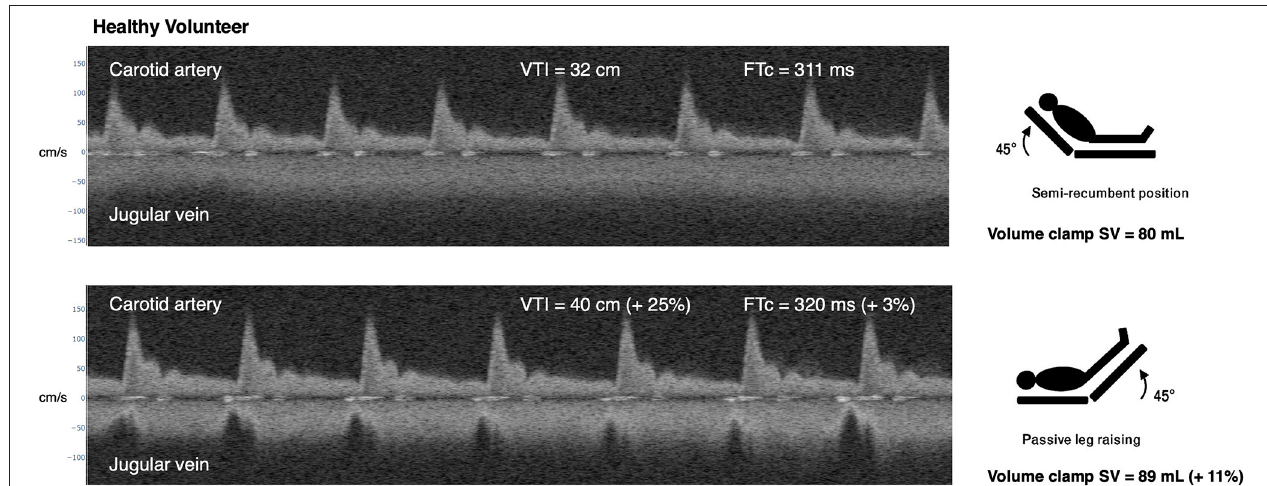
FIGURE 3 | Example of simultaneous carotid arterial and jugular venous Doppler in healthy subject during passive leg raise. At baseline, in semirecumbent, the subject has continuous (low P ra ) jugular venous Doppler morphology. Upon passive leg raise (PLR), the venous morphology transitions to a pulsatile morphology suggesting a rise in P ra. There is augmentation of carotid arterial Doppler metrics during PLR and SV by non-invasive volume-clamp. Compare this response to the “normal” P ra -SV relationship in Figure 1 . VTI is velocity time integral in centimeters, cm. FTc is corrected flow time in milliseconds, ms. SV is stroke volume in milliliters, ml. cm/s is centimeters per second.